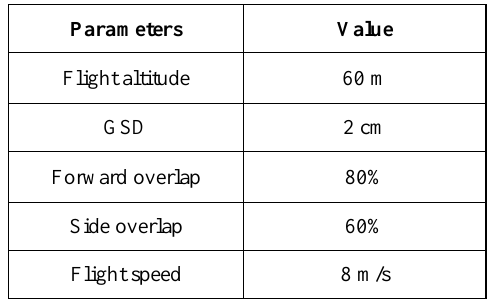
Table 1. Summary of flight parameters